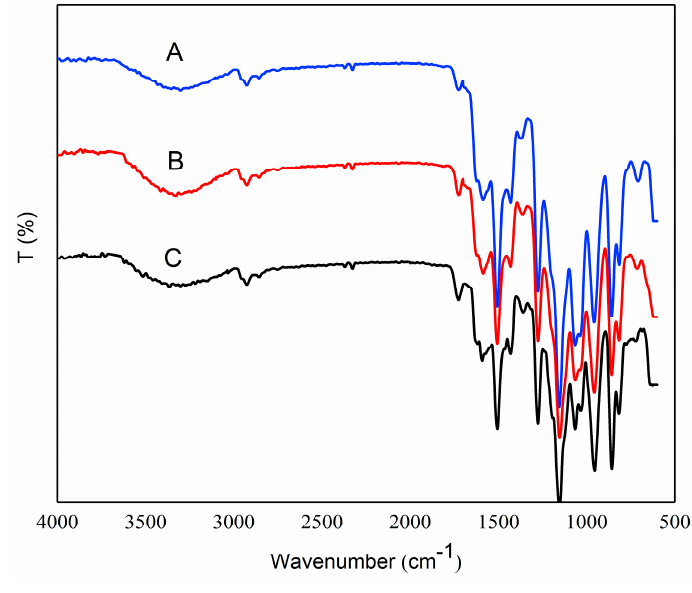
Figure 4. FTIR curves: OSA 0.25 –SGC–CUR—A, OSA 0.5 –SGC–CUR—B and OSA 1.0 –SGC–CUR—C mixture.